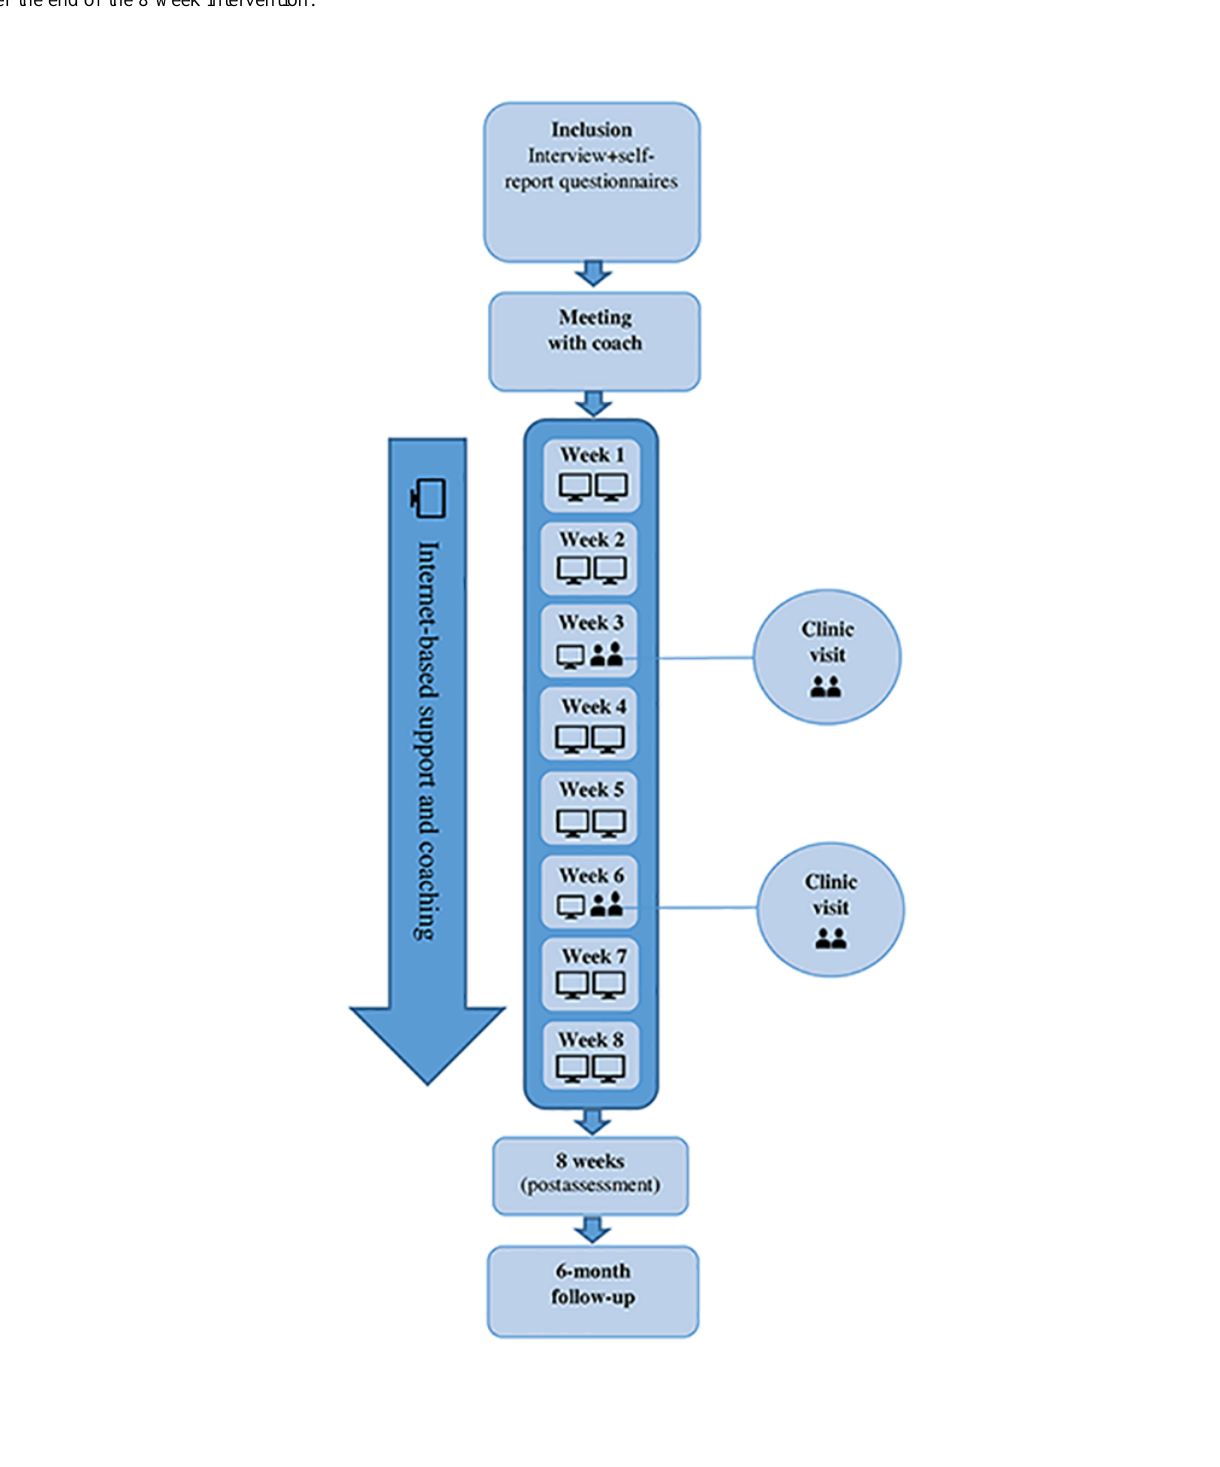
Figure 2. Flowchart of the internet-based support and coaching model. Assessment at 8 weeks (postassessment): assessment was carried out immediately after the end of the 8-week